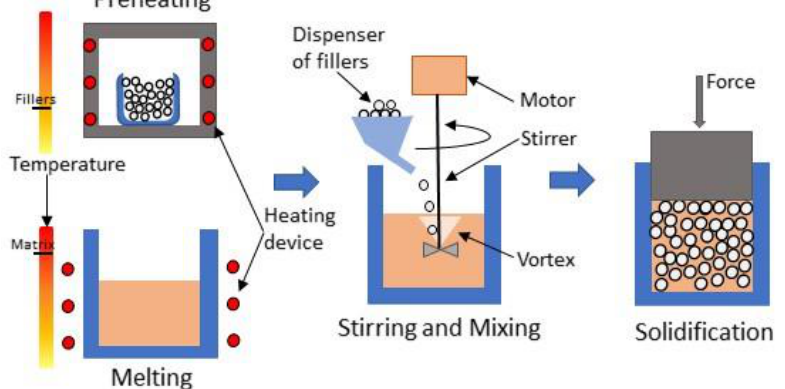
Figure 3. Modified stir casting Route 1 process scheme for MMSFs. Table 3. Range of values of parameters governing modified stir casting, Route 1 (MSC-1) process.